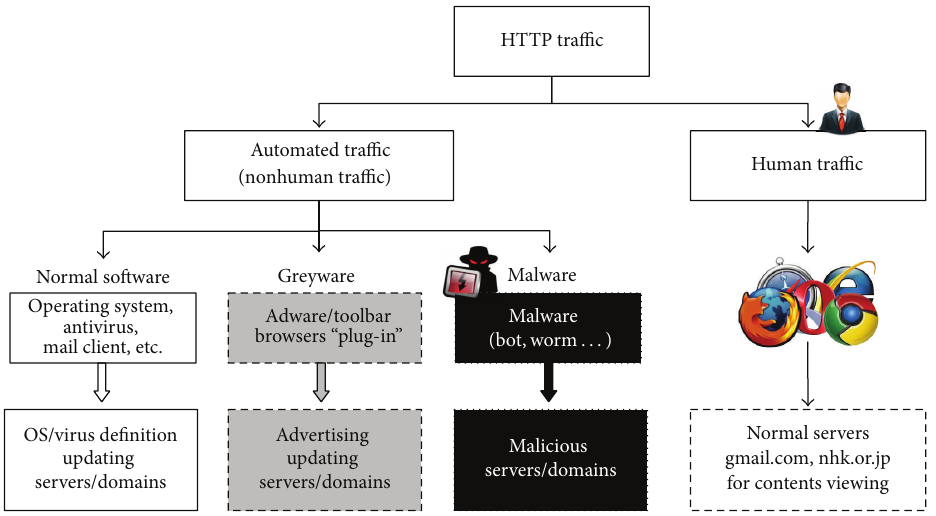
Figure 1: HTTP traffic and automated software